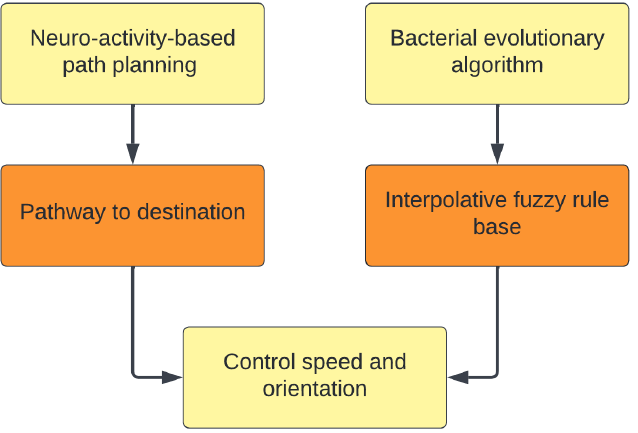
Figure 17. The interaction between the components of the control